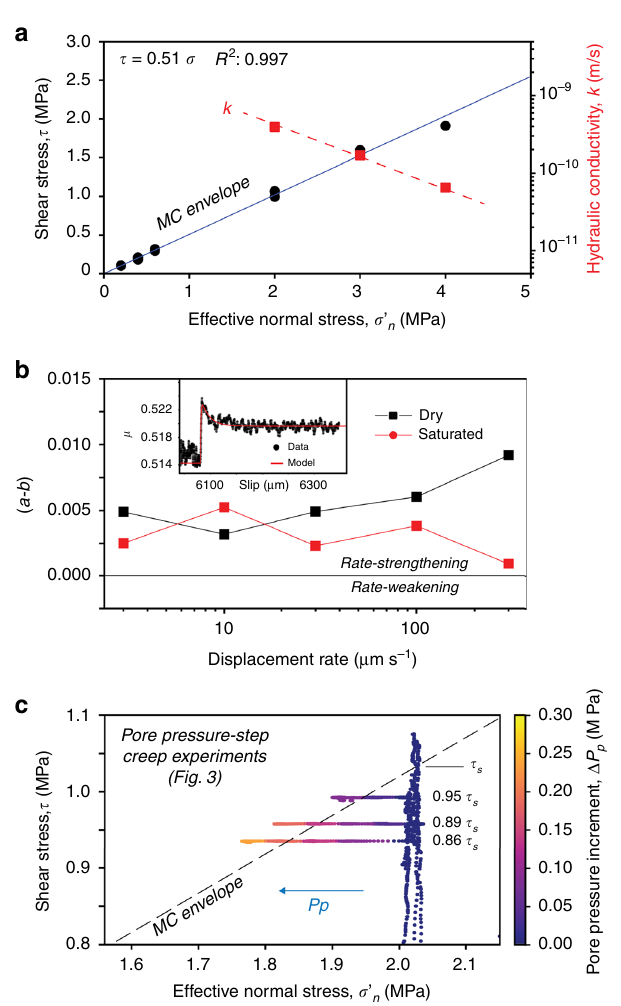
Fig. 2 Friction, fl uid fl ow properties, and stress evolution during fl uid pressurization. a Frictional and hydraulic properties of the tested natural gouge, derived from stable-sliding laboratory tests; b rate-and-state frictional properties of the tested natural gouge, derived from velocity-step tests. Inset shows a typical velocity step along with the model inversion performed to retrieve the ( a – b ) values; c experimental stress paths during pore-pressure-step creep experiments. In these experiments, we started with an initial stage at constant displacement rate (10 µ m s − 1 ) to achieve the instantaneous shear strength ( τ s ). Then we fi xed constant shear stress at 86, 89, and 94% of τ s and started creep experiments (details are reported in method and Fig. 7). Errors (standard deviation) are smaller than symbols